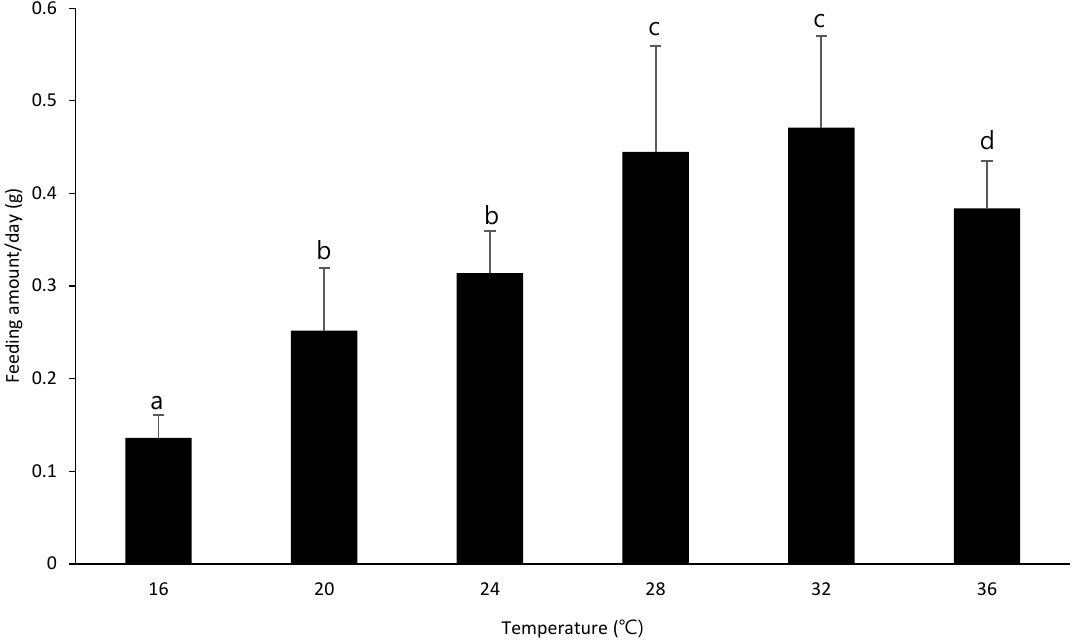
Figure 4. Daily corn leaf feeding amount of Spodoptera frugiperda according to temperature (The same letters are not significantly differenct ( p > 0.05) by Tukey’s HSD test). Luginbill (1928) [30] reported that the crabgrass intake ratio from the first to sixth instar larvae of S. frugiperda was 0.1, 0.6, 1.1, 4.7, 16.3, and 77.2, respectively. Calculated by area, they were 20.75, 82.25, 149, 644.5, 2,244.7, and 10,665 mm 2 . We calculated the food